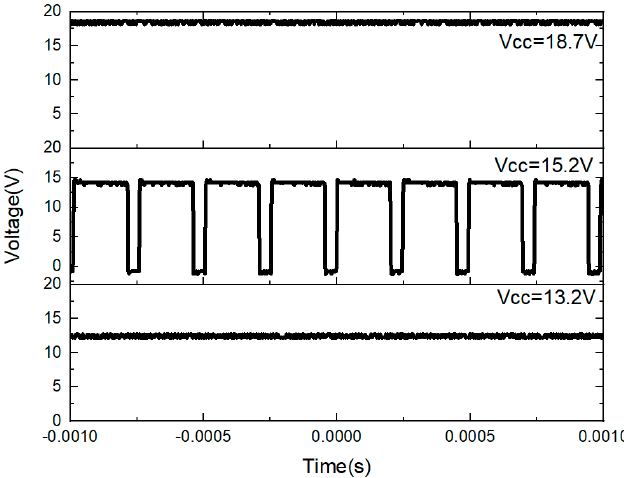
Figure 14. Measured waveforms at the drain pin under different VCC voltages (Sample A).